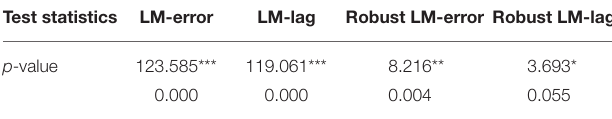
TABLE 6 | Test values of LM test